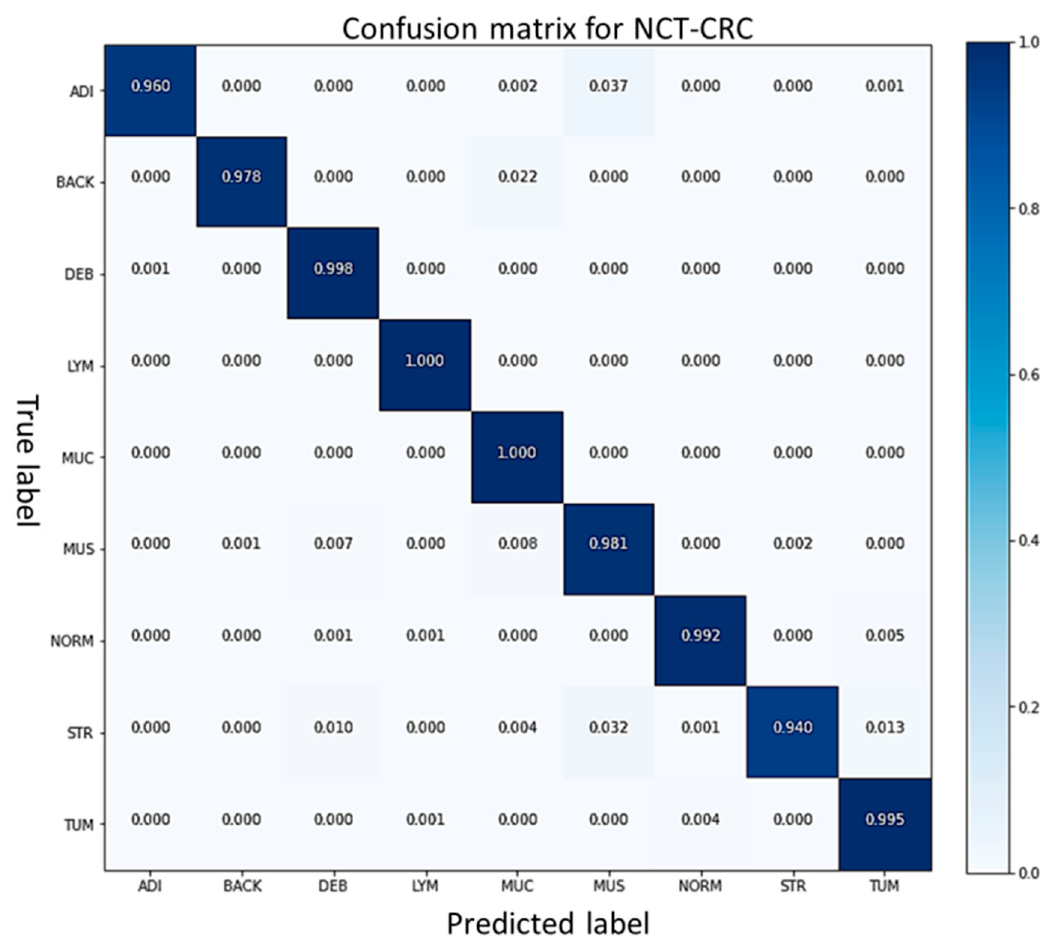
Figure 10. Confusion matrix of FabNet, which shows the best score in the NCT-CRC-HE-100K dataset testing set among 5-fold cross-validation.